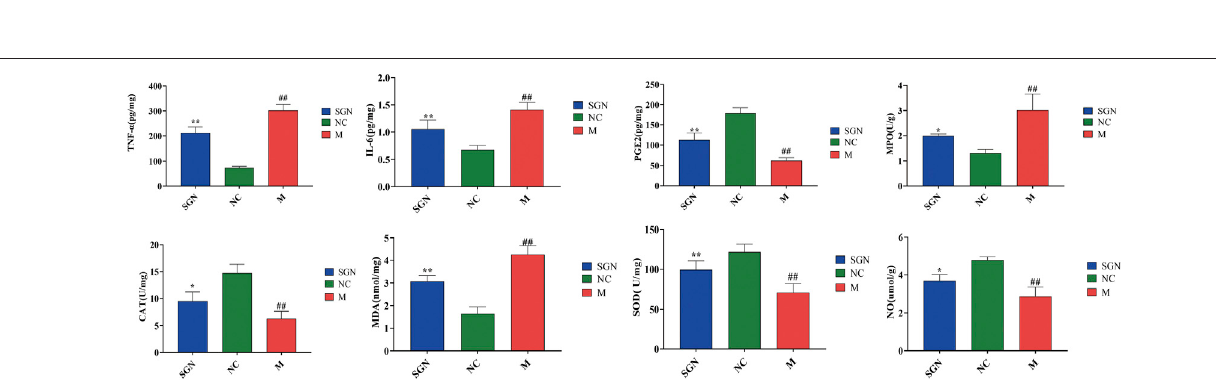
Frontiers in Pharmacology |